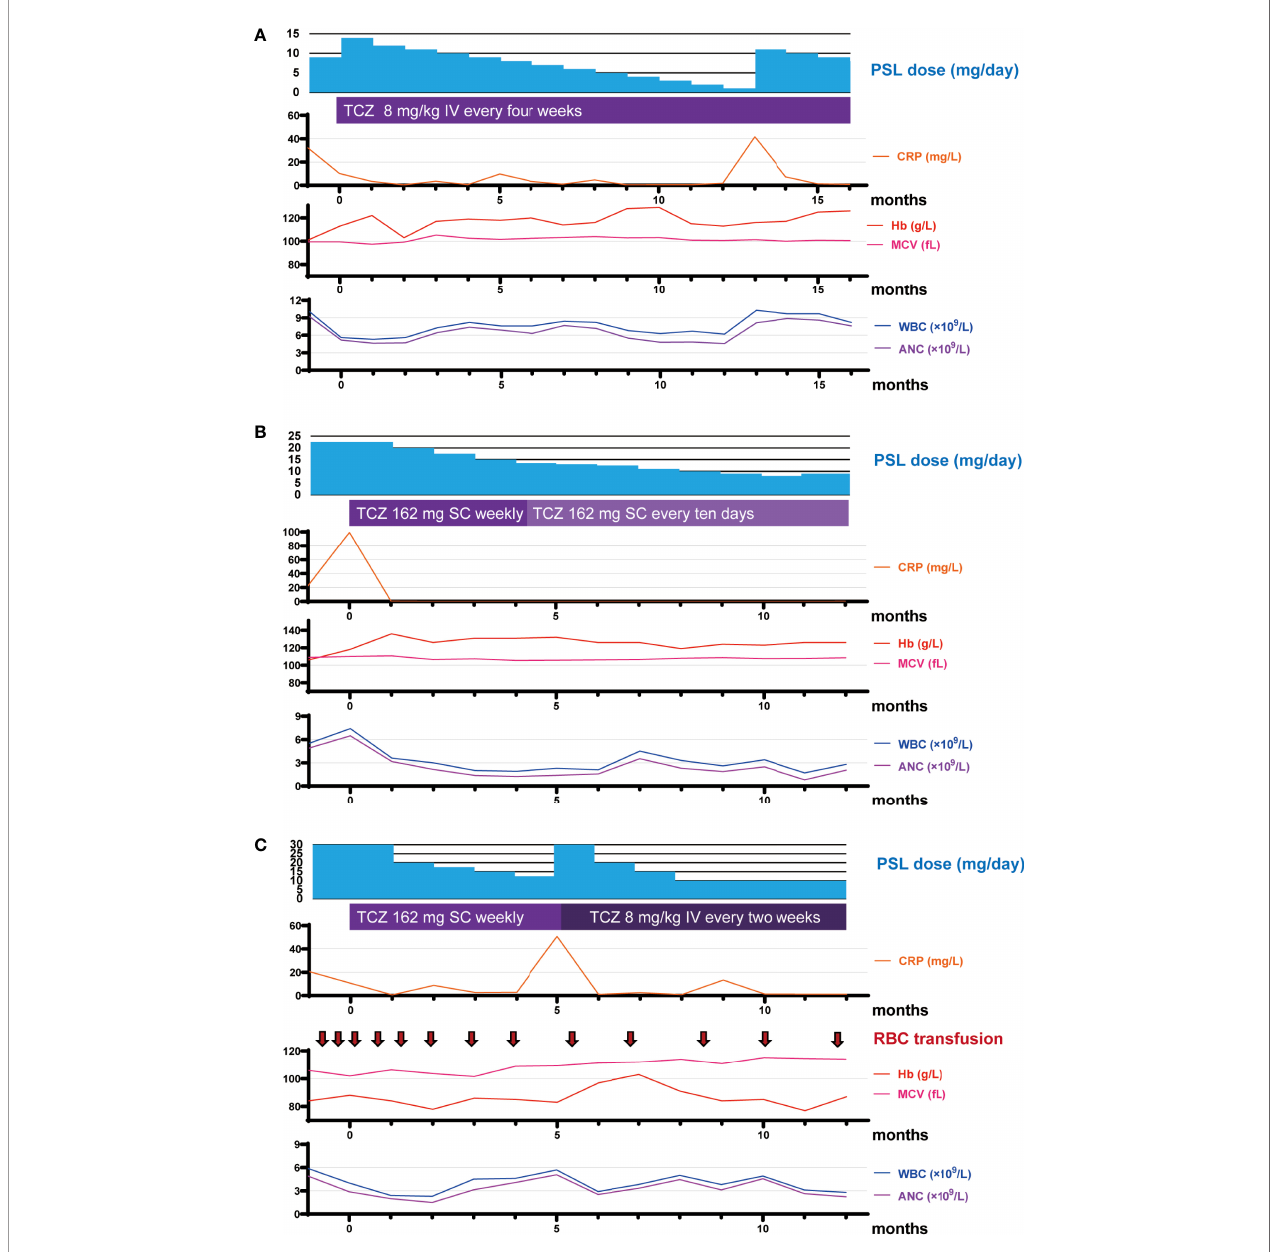
FIGURE 1 | Timeline of medication and laboratory data over the course of the study period. (A – C) Timeline of medication and laboratory data for RP13 (A) , RP15 (B) , and RP16 (C) over the course of the study period. Month 0 represents the time of TCZ initiation. ANC, absolute neutrophil count; CRP, C-reactive protein; Hb, hemoglobin; IV, intravenous injection; MCV, mean corpuscular volume; PSL, prednisolone; RBC, red blood cell count; SC, subcutaneous injection; TCZ, tocilizumab; WBC, white blood cell